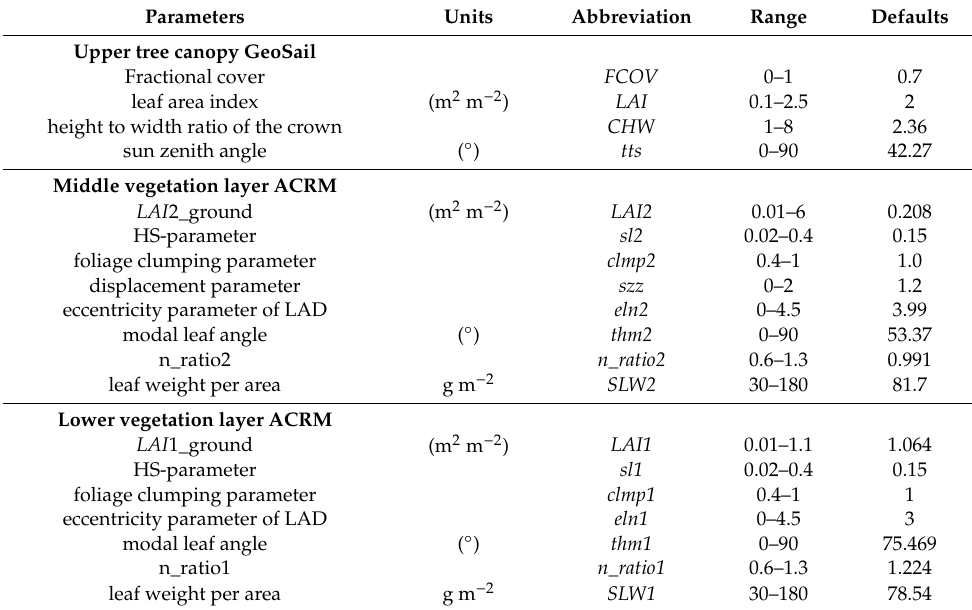
Table 2. The input canopy vegetation parameters are used for the parameterization of the coupled Radiative Transfer Model (RTM). The simulation of radiative transfer characteristics of upper vegetation was based on GeoSsail model, while that of middle and lower vegetation layers was based on the A two-layer Canopy Reflectance Model (ACRM)